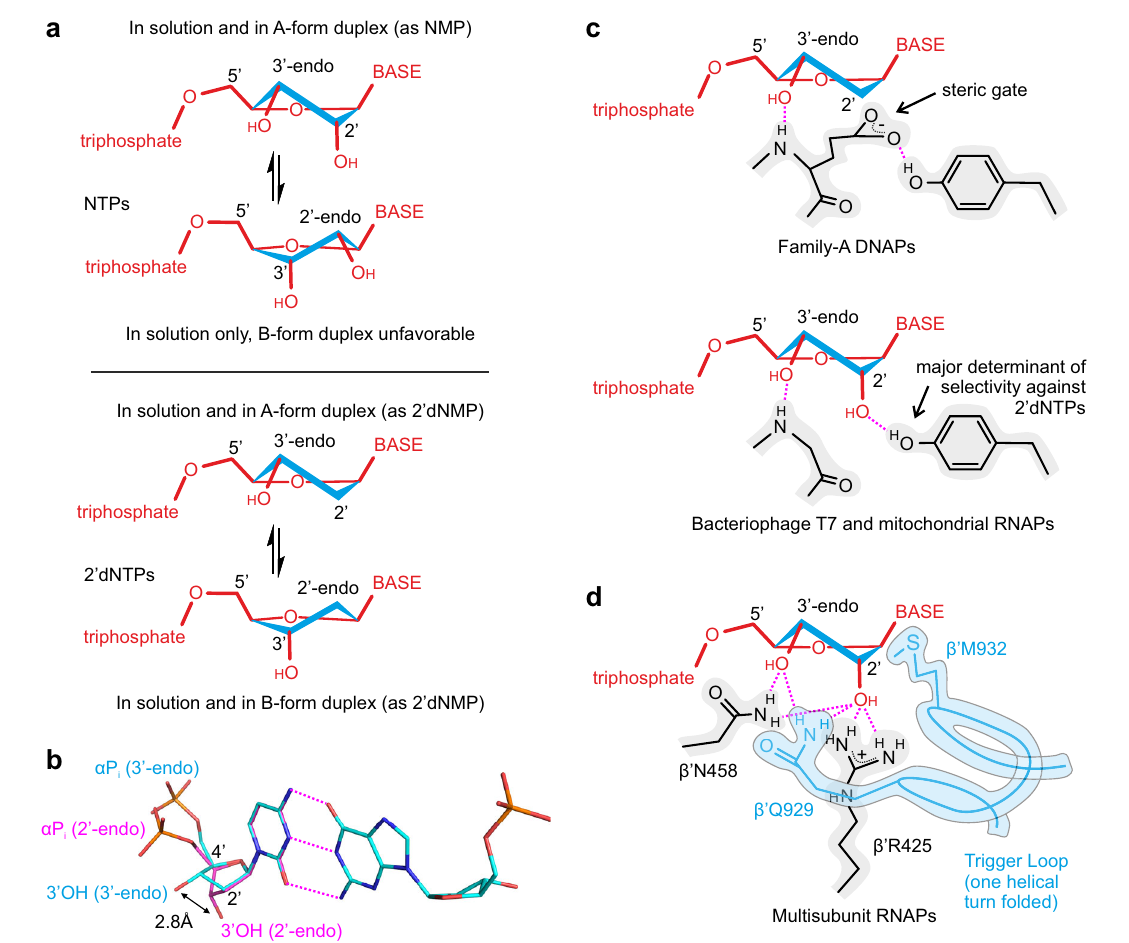
Fig. 1 Recognition of NTPs and 2 ′ dNTPs by nucleic acid polymerases. a NTPs and 2 ′ dNTPs equilibrate freely between 3 ′ -endo and 2 ′ -endo conformations in solution. A- and B-form duplexes of RNA and DNA constrain sugar moieties of nucleotides in 3 ′ -endo and 2 ′ -endo conformations, respectively. C1 ′ – C2 ′ – C3 ′ – C4 ′ bonds of the sugar moieties are colored cyan. b Watson – Crick base pairing of the 3 ′ -endo (cyan) and 2 ′ -endo (magenta) conformers to the template nucleic acid results in markedly different positions of the 3 ′ OH group and the α -phosphate relative to the base-pairing plane. c , d DNAPs and RNAPs stabilize 3 ′ -endo conformers of their cognate substrates. The illustrations re fl ect the crystallographically documented arrangement of the active site residues but are not accurate projections of 3D structures. Dashed magenta lines depict polar interactions and hydrogen